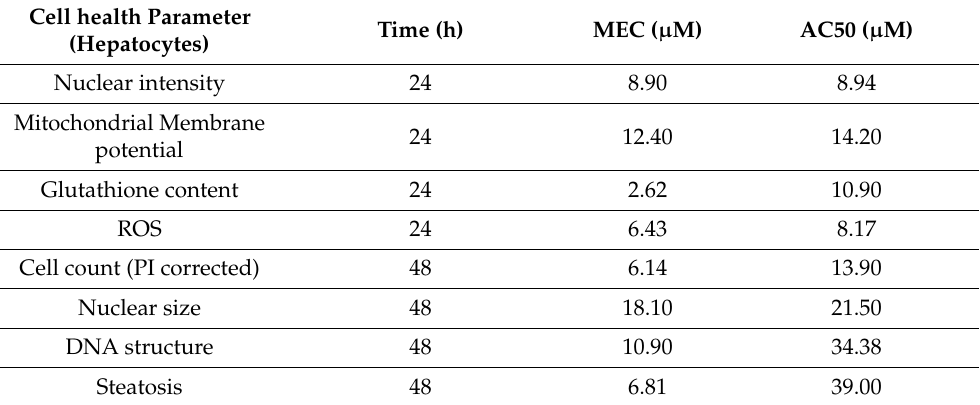
Table 1( B ) NV651 MEC and AC 50 values in primary human hepatocytes evaluated for